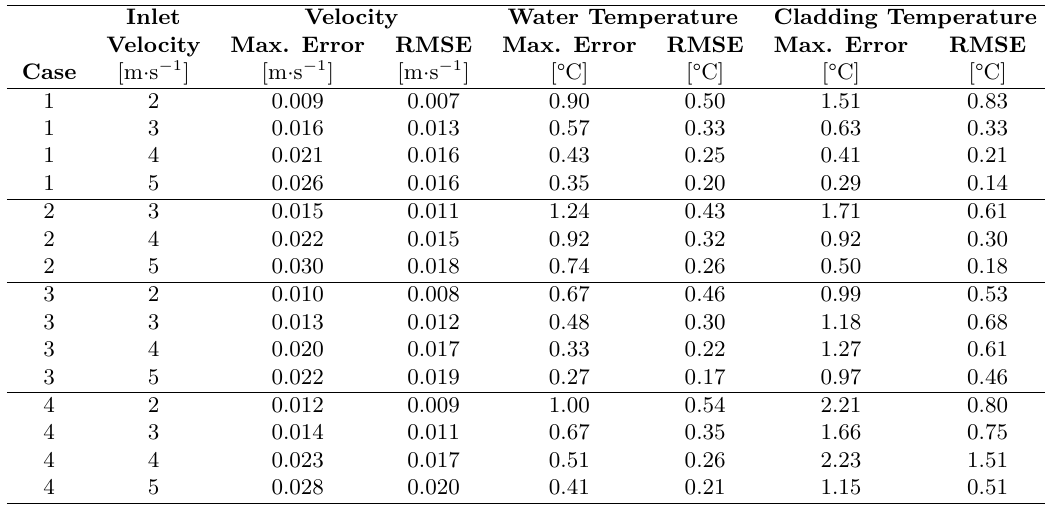
Table 2. Code-to-code comparison for different power profiles.